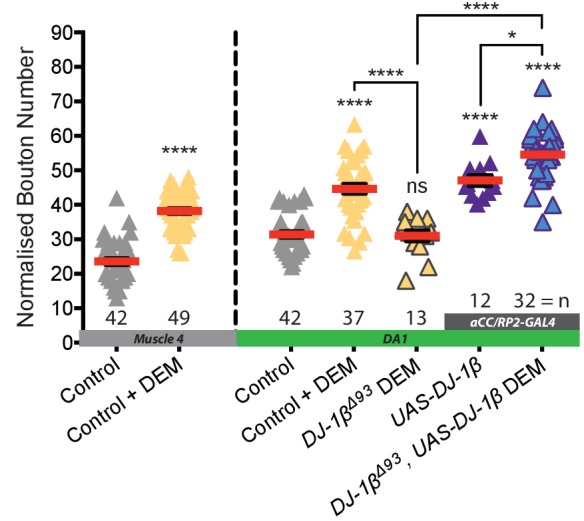
10 mM DEM feeding induces increased bouton number at both muscle four and DA1.This response is absent in DJ-1β null mutant larvae and is re-established via neuronal (aCC and RP2) specific miss-expression of UAS-DJ-1β. UAS-DJ-1β expression alone elevates bouton number, which is exacerbated when combined with DEM feeding. Normalised bouton number dot plot, Control is aCC-FLP-GAL4 alone in heterozygous condition. Mean ± SEM, ANOVA *p<0.05, ****p<0.0001, n = replicate number.